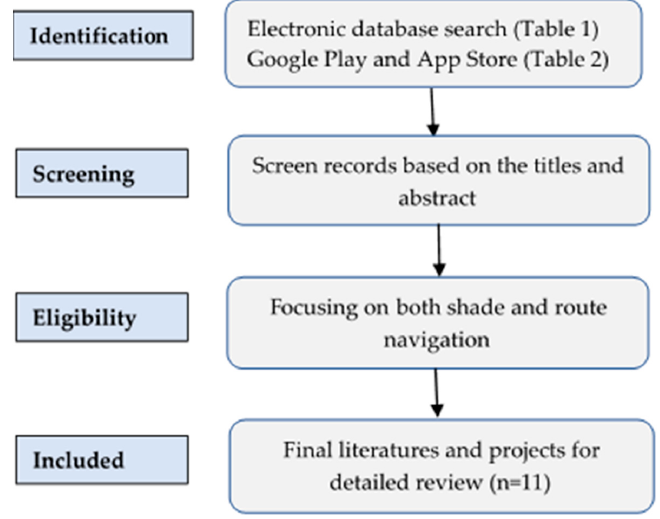
Figure 2. The steps adopted in the systematic review process.